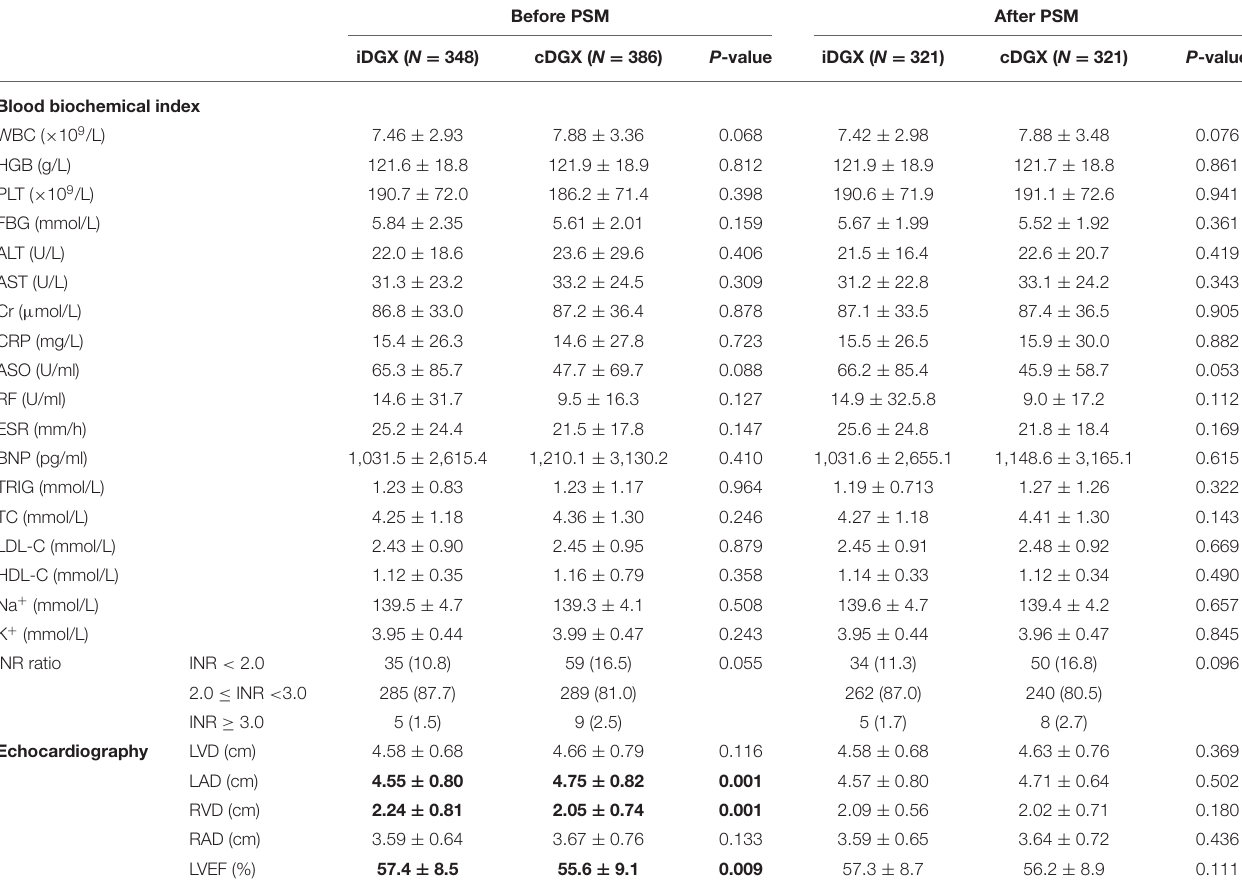
TABLE 2 | Baseline laboratory and echocardiography profile of study subjects.